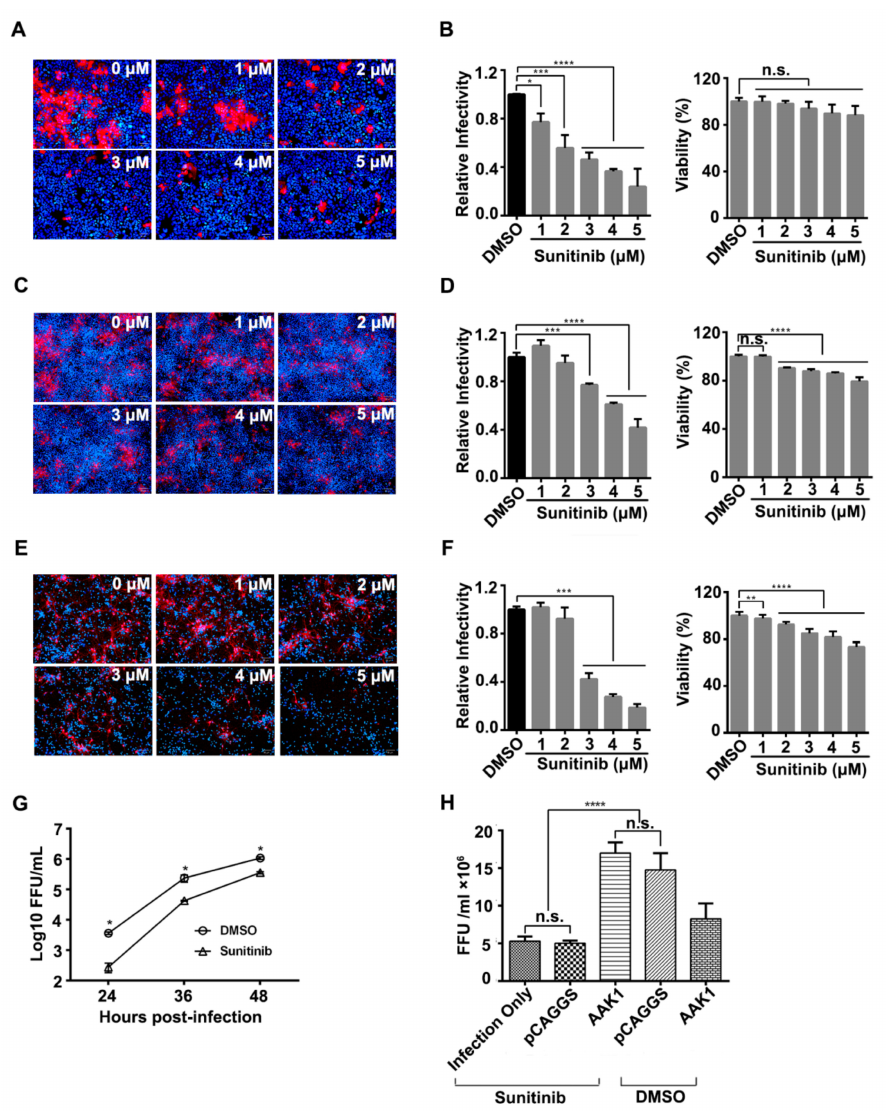
Figure 2. Inhibition of AAK1 kinase activity decreases RABV infection in vitro. ( A – F ) Cells were pretreated with di ff erent concentrations of sunitinib or DMSO for 1 h at 37 ◦ C before infection with ERA-mCherry at an MOI of 0.01. At 48 h post-infection, a high-content quantitative image-based analysis was used to measure the relative infection ratio (normalized to NT siRNA-treated cells) of ERA-mCherry in HEK-293 cells ( A ), SK cells ( C ), and mPN cells ( E ). The viability of HEK-293 cells ( B ), SK cells ( D ), and mPN cells ( F ) treated with the indicated concentrations of sunitinib was determined using CellTiter-Glo reagent. Data are relative fluorescence values normalized to the level of the NT control. A one-way ANOVA was used for the statistical analysis. **, p < 0.01, ***, p < 0.001, ****, p < 0.0001; n.s., not significant. ( G ) HEK293 cells were treated with sunitinib (2 µ M) or DMSO and then infected with ERA-mCherry (MOI = 0.01). Viral titers were determined at the indicated time points. Multiple t-tests were used for the statistical analysis, *, p < 0.05. ( H ) Sunitinib counteracted the e ff ect of AAK1 overexpression on RABV infection. HEK293 cells were transfected with pCAGGS-AAK1 and pCAGGS. At 48 h post-transfection, cells were treated with sunitinib and subsequently infected with ERA-mCherry at an MOI of 0.1. Viral titers in the supernatant were determined at 48 h post-infection and were normalized to that of the “infection only” group. Tukey’s multiple comparisons test was used to analyze the statistical di ff erence. ****, p < 0.0001; n.s., not